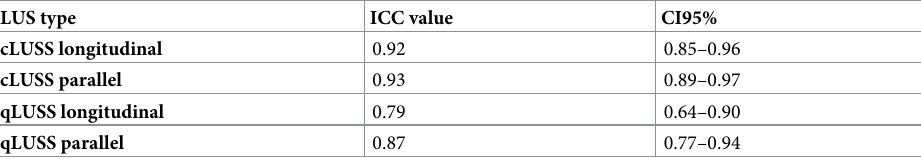
Table 5. Interobserver agreement of summarized BLUE-LUS scores.